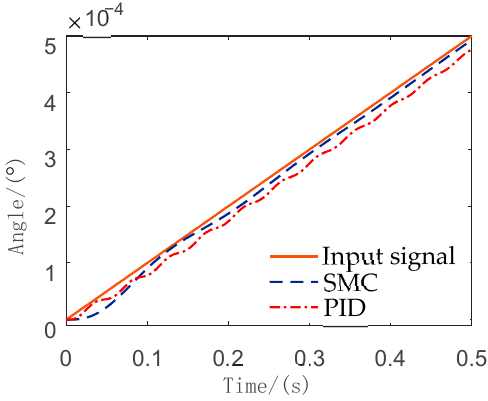
Figure 7. Comparison of slope response simulation.